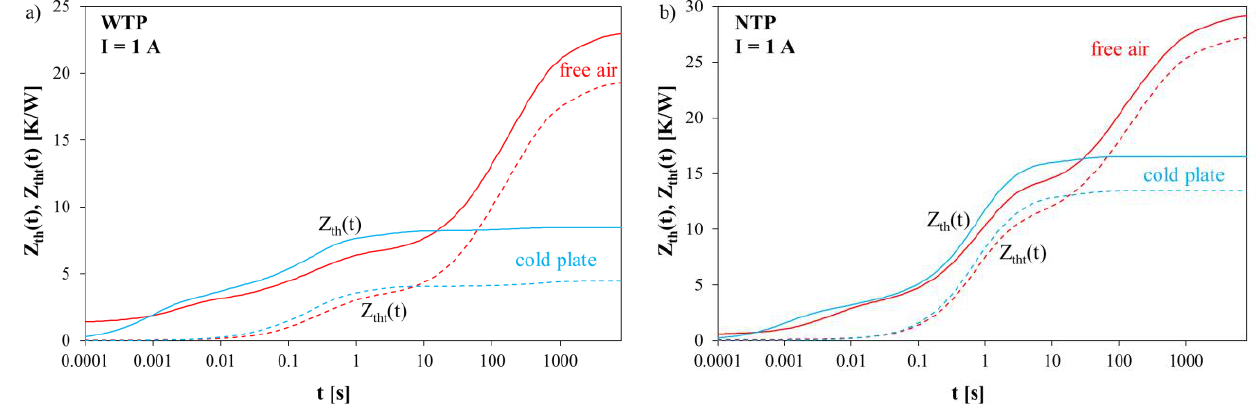
Energies 2021 , 14 , x FOR PEER REVIEW